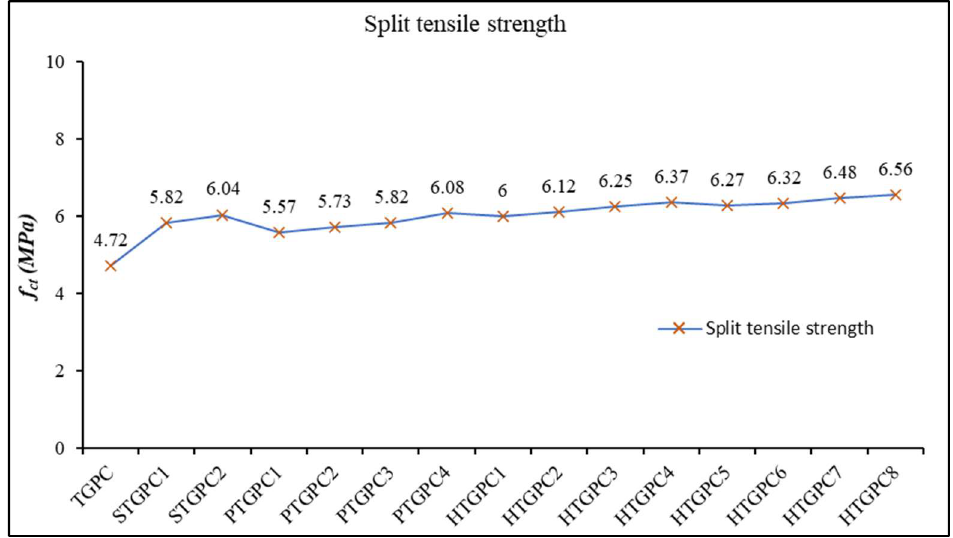
Figure 5. Comparison of split tensile strength.